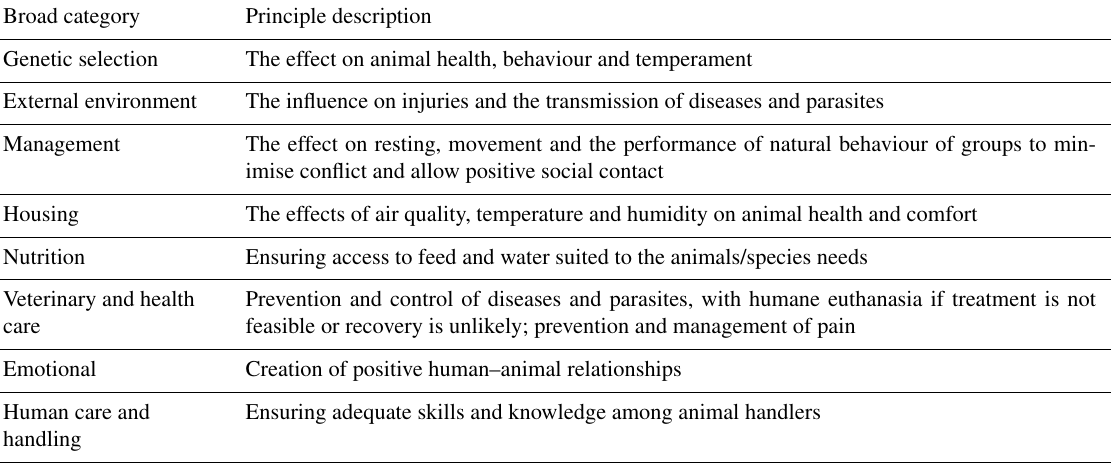
Table 1. Principles for the welfare of animals in livestock production (adapted from OIE, 2012).